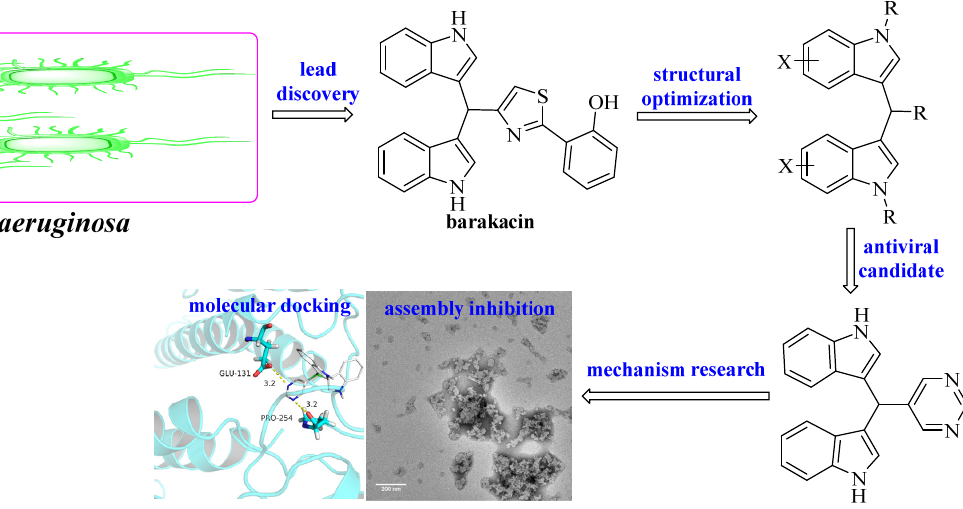
Figure 1. Molecular design and structural optimization based on barakacin.